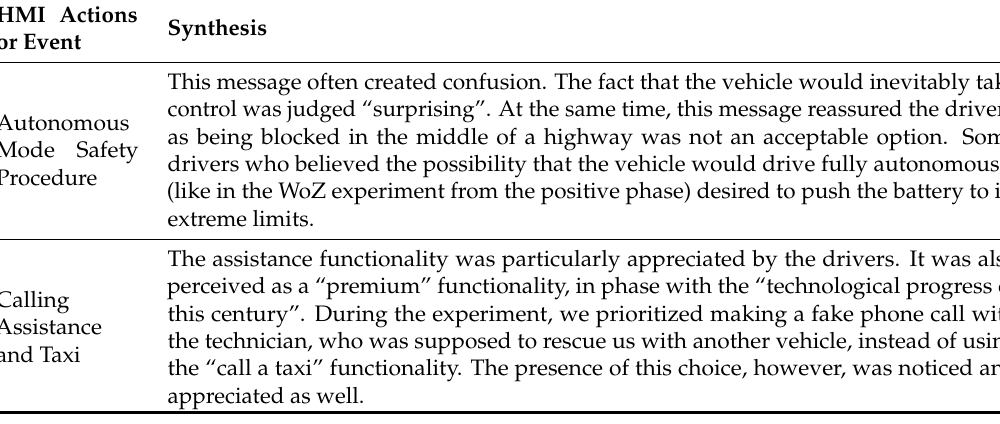
Table 3. Synthesis in terms of user experience per event and HMI actions taken in Scenario C. Further details and more verbatims from this scenario are available in Appendix A.3.